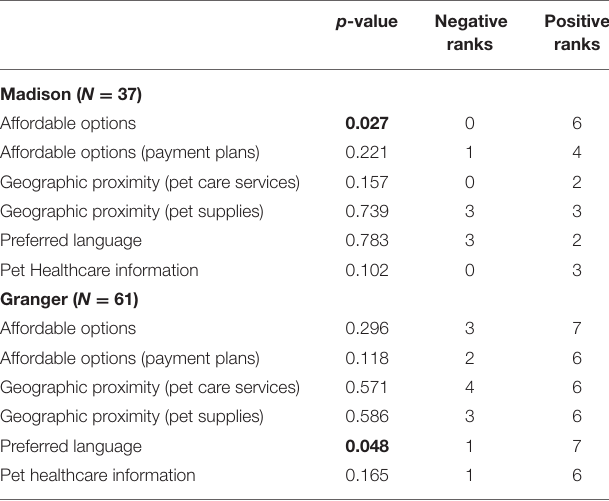
TABLE 7 | Wilcoxon-signed rank test to examine perceptions of access to pet care pre-intervention and post-intervention for PFL clients.